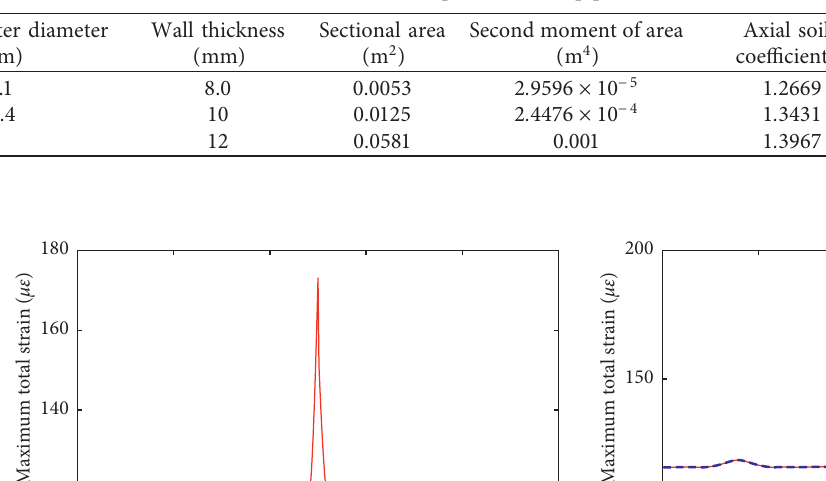
Table 7: The parameters of pipes with different diameters.